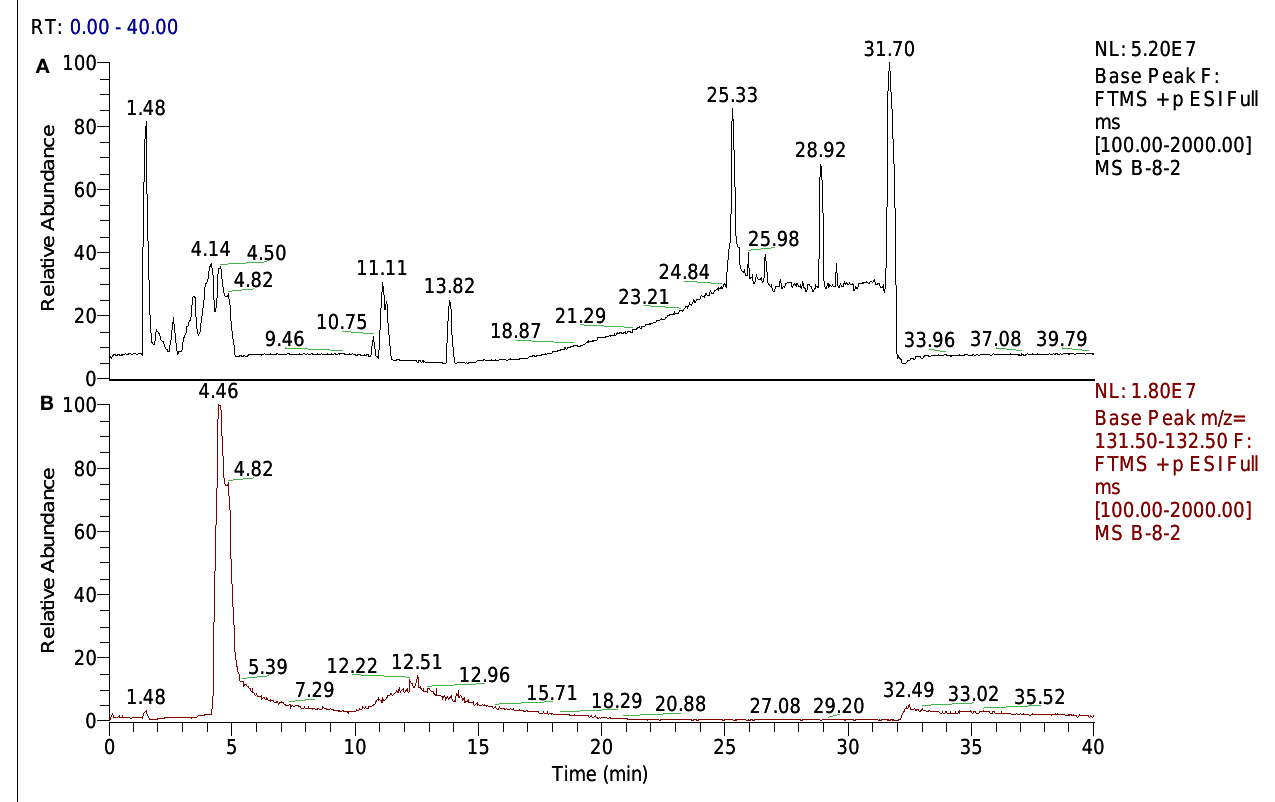
FIGUREA6 | RP-HPLC-ESI-MS (Orbitrap) base peak chromatograms of xylem sap of plants not challenged with arsenate. (A) the whole mass range ( m / z 100–2000) and (B) the mass range m / z